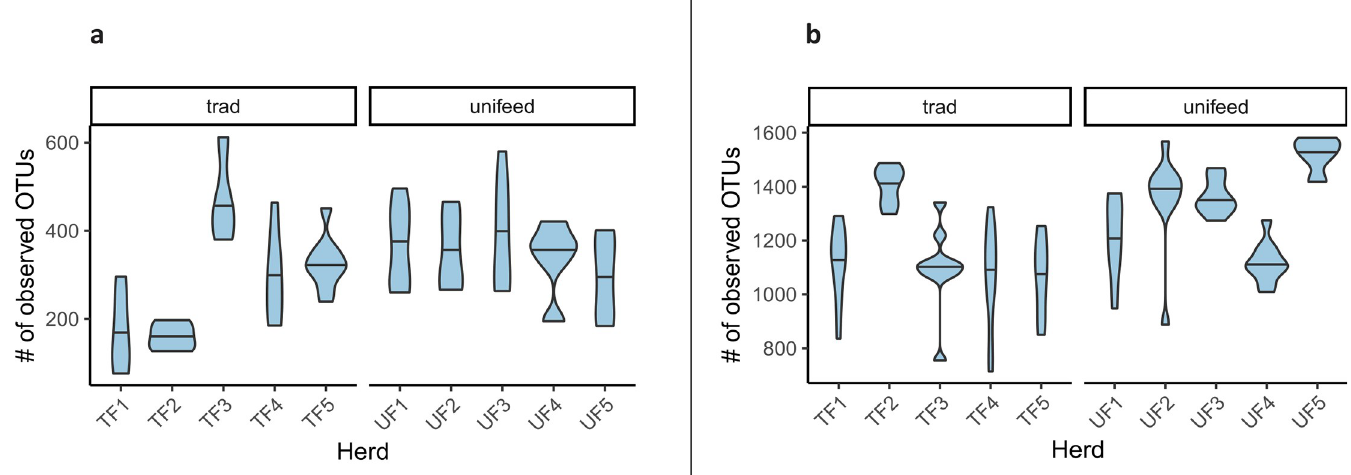
Fig 3. Estimates of microbiota richness. Violin plot of the total number of observed OTUs of Alpine dairy cow raw milk (a) and fecal (b) microbiota.